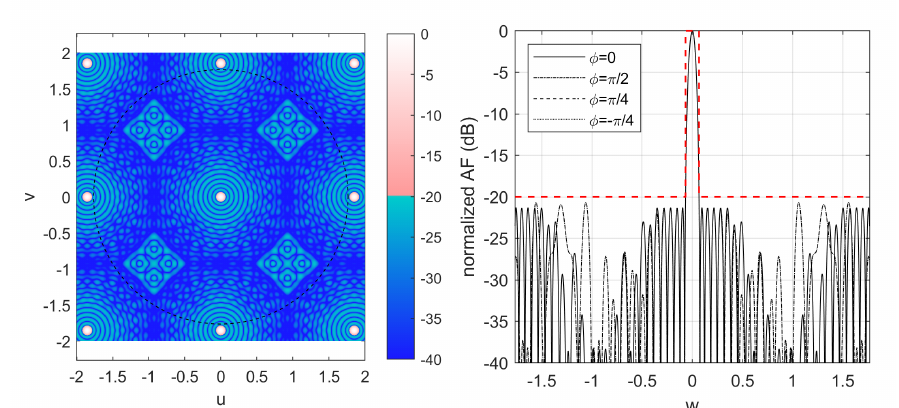
Figure 2. Square regular lattice array with 665 elements. Left subplot: imagemap with the power pattern of the radiated pattern. Right subplot: some relevant cuts for the normalized array factor (AF) of the radiated pattern. Negative values of w are related to the cuts φ (cid:48) = φ + π .